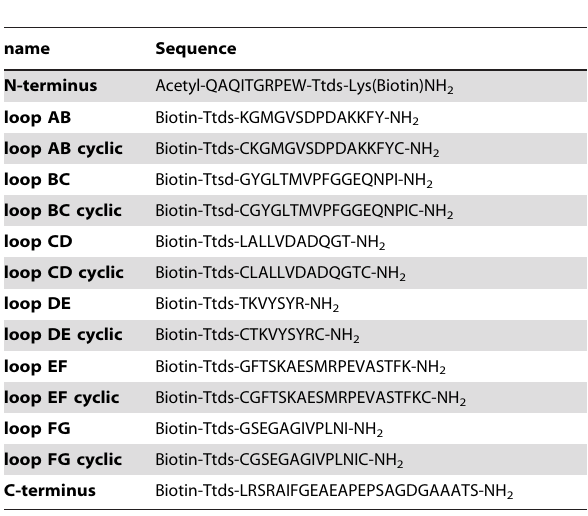
Peptides were biotinylated to allow capturing on streptavidin coated plates. Ttds ((N-(3-{2-[2-(3-Amino-propoxy)-ethoxy]-ethoxy}-propyl)-succinamic acid) was used as spacer between the biotin and the peptide to reduce steric hindrance. All peptides were C-terminally